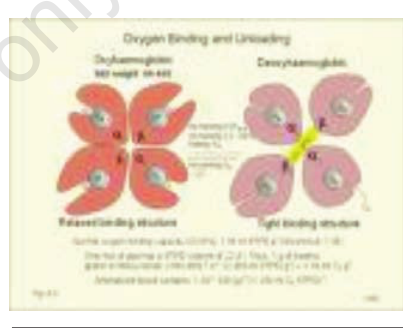
Figure 2. Oxy versus deoxyhemoglobin. 15 Legend: a = Alpha globins; β = Beta glo- bins.